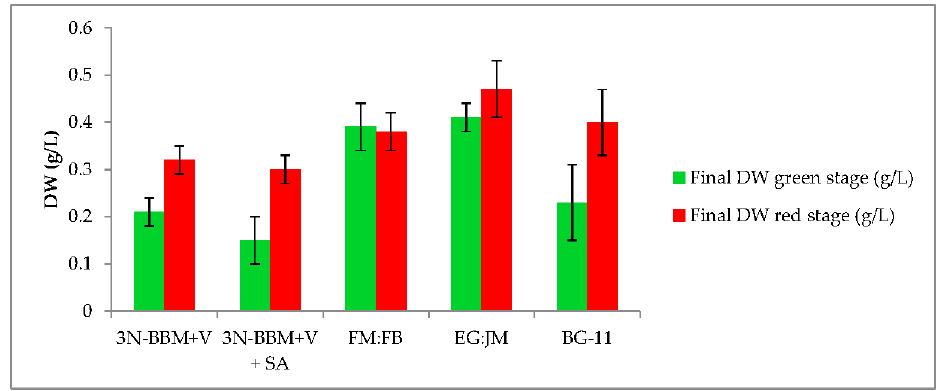
Figure 5. Dry weight (DW) yields of green and red stage ( H. pluvialis cultured in a range of media under autotropic and mixotrophic conditions). Mean DW (g·L − 1 ) ± S.D. ( n = 3). Green stage involved culturing at 20 °C, 40 µmol photons m − 2 ·s − 1 , 12:12 photoperiod, 150 rpm over a 10-day period. Red stage involved culturing at 20 °C, continuous light at 240 µmol photons m − 2 ·s − 1 over a 12-day period.